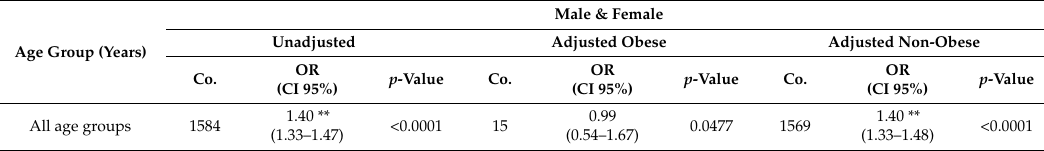
Table 2. Overall association between T1DM and KOA among obese and non-obese subjects. Co.: co-occurrence, OR: odds ratio. ** indicate p -value less than 0.0001. Male & Female Unadjusted Adjusted Obese Adjusted Non-Obese Age Group (Years) Co. OR (CI 95%) p -Value Co. OR (CI 95%) p -Value Co. OR (CI 95%) p -Value All age